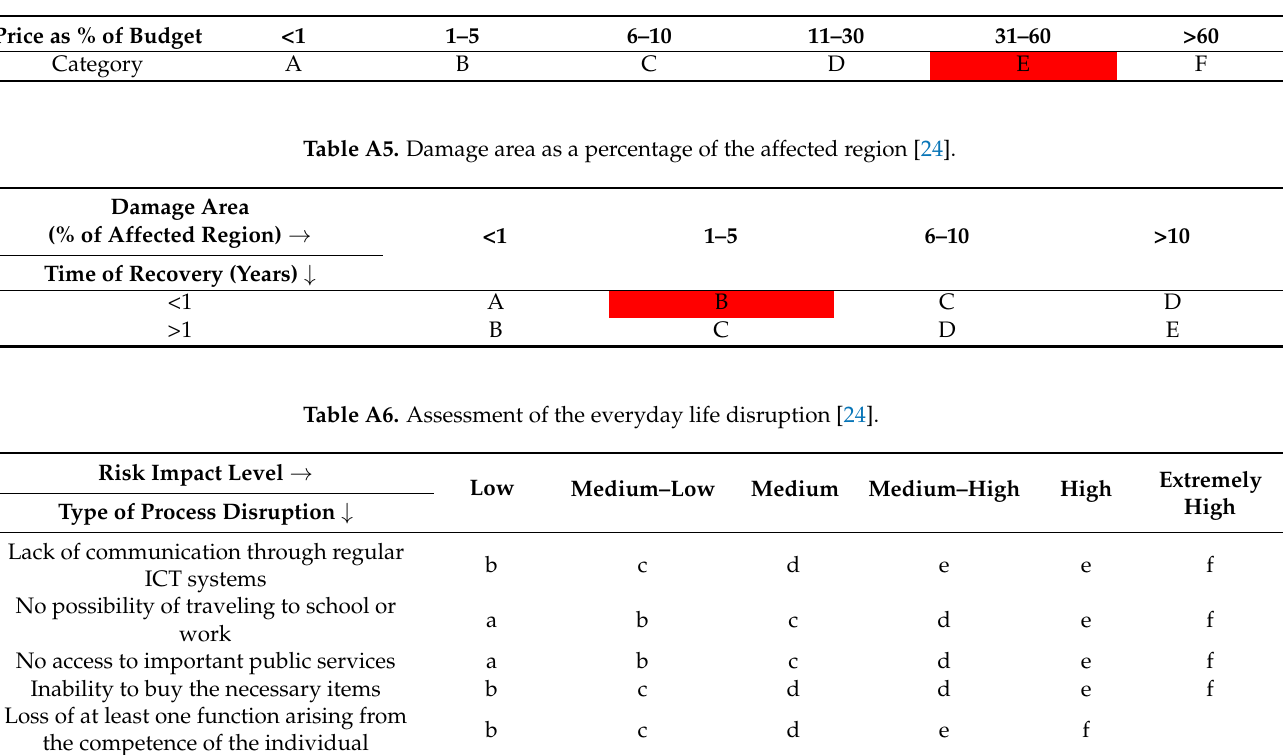
Table A4. Percentage of the commune budget [24].